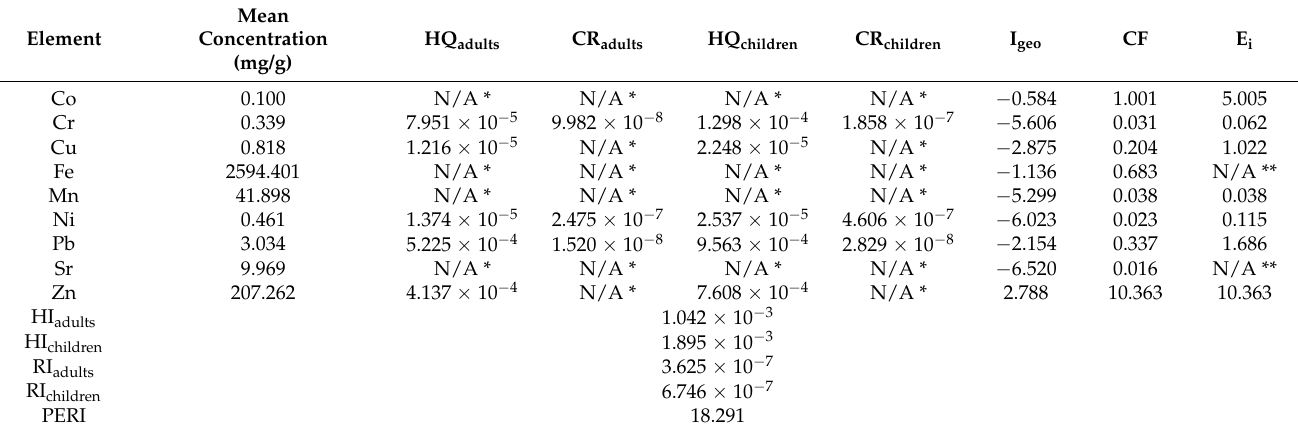
Table 9. Results for the Health Risk Assessment and the Potential Ecological Risk Assessment variables 3